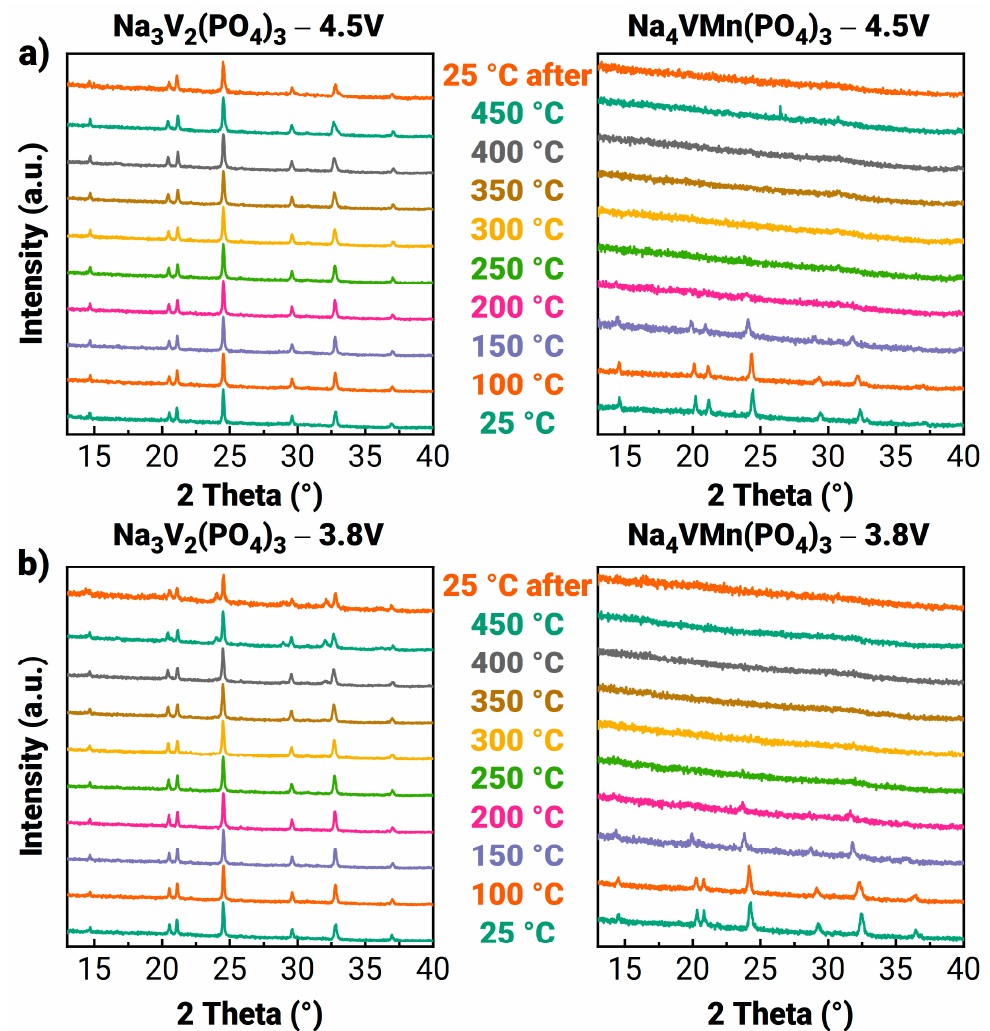
Figure 6. In situ HTPXRD patterns for the charged electrodes containing Na 3 V 2 (PO 4 ) 3 and Na 4 VMn(PO 4 ) 3 cathode materials (( a ) 4.5 V and ( b ) 3.8 V). Na 4 VMn(PO 4 ) 3 cathode materials (( a ) 4.5 V and ( b ) 3.8